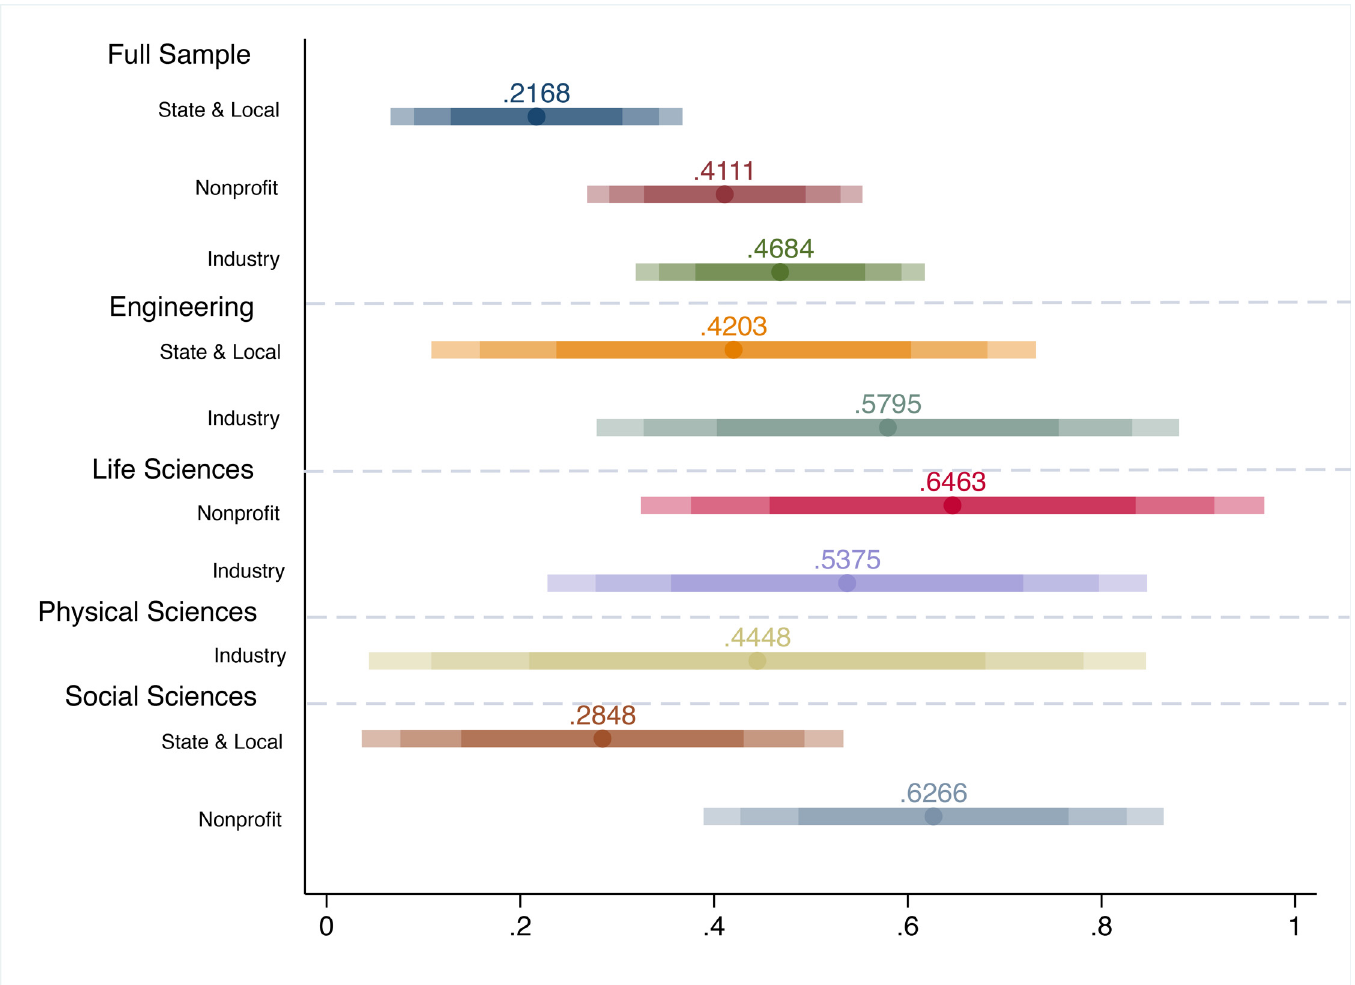
Fig 2. Robust Federal R&D Elasticity Confidence Intervals by Broad Academic Field and Non-Federal Source of Funding. Notes : Confidence intervals of elasticities from Eq 1 estimations are presented along the x-axis (95%, 90%, and 75%). Elasticity values are presented only if the results for the primary outcome – federal R&D funding – are efficient and consistent to the following additional model specifications: the alternate dynamic panel model (Eq 4), and the fixed effects model (Eq 2). The y-axis reports the sample stratifications with the respective outcome listed for each confidence interval. The dashed horizontal lines delimit the